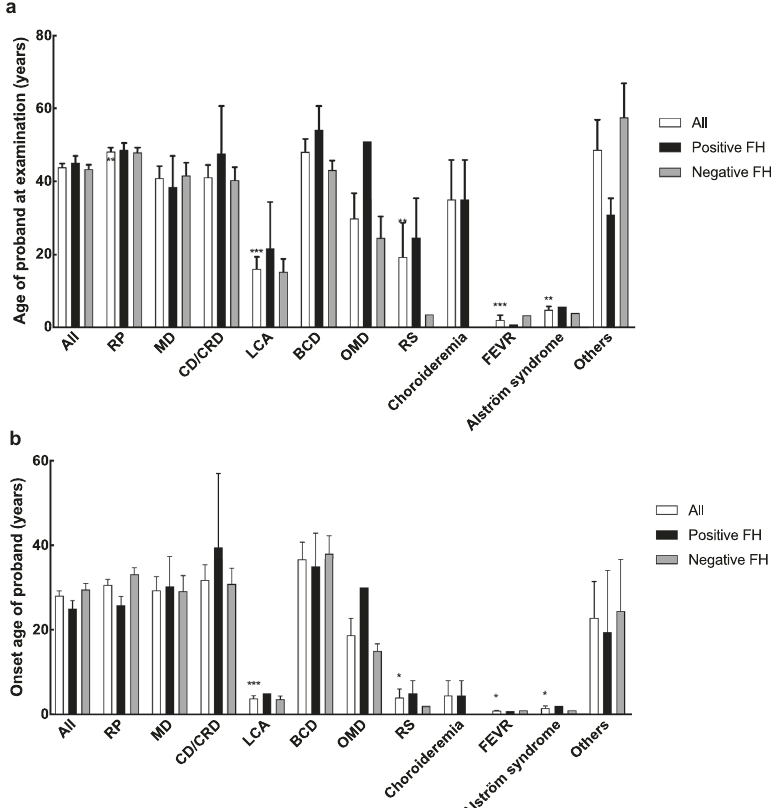
Fig. 1 The age at examination and at onset of IRD probands by phenotype. a The age at examination of all probands or of probands with a positive/negative family history. b The onset age of all probands or of probands with a positive/negative family. Means with different symbols are statistically signi fi cant compared to all probands by Fisher ’ s LSD test (*** p < 0.001; ** p < 0.01; * p < 0.05). FH family history.